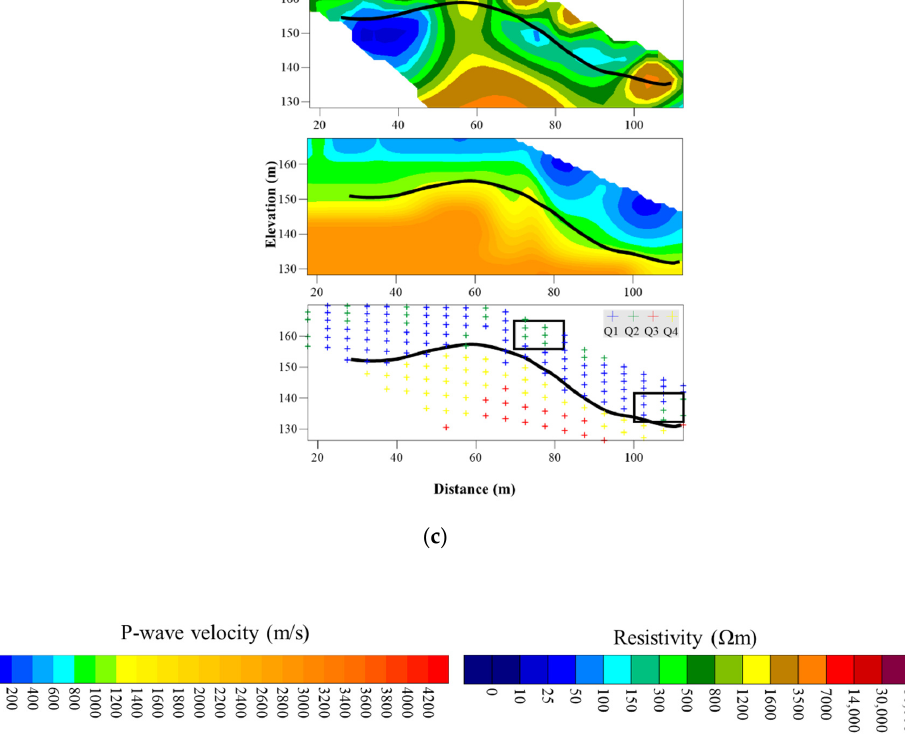
Figure 12. 2-D cross-plot model of integrated 2-D resistivity and seismic refraction: ( a ) HR1 and HS1; ( b ) HR2 and HS2; ( c ) HR4 and HS3.